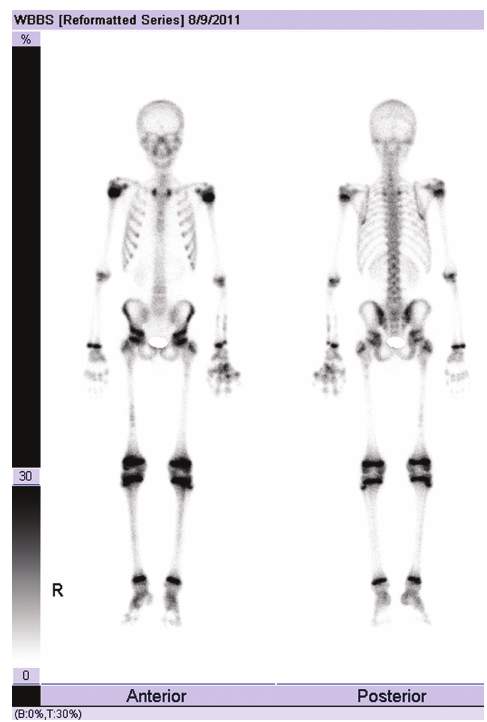
Figure 8: Tc-99m MDP WBBS before operation demonstrated intensive radioactive accumulation in multiple metacarpophalangeal and interphalangeal joints of left hand, left ulna, left radius, and right